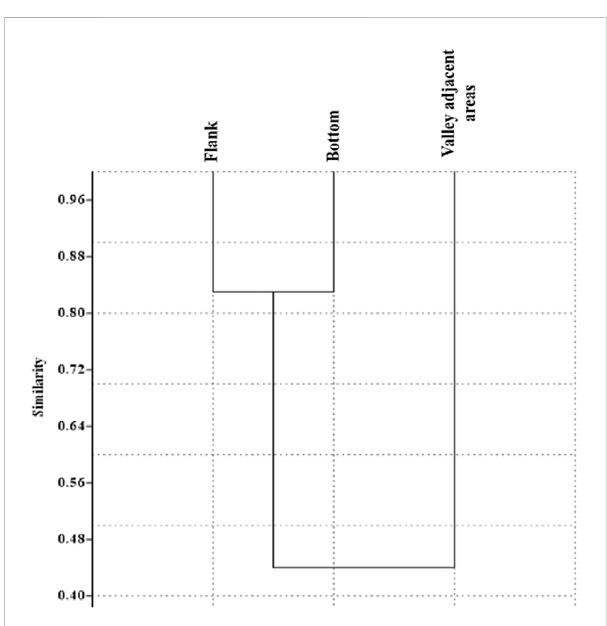
FIGURE 7 Similarity (Bray Curtis) in biotic composition among the valley bottom, valley fl ank, and adjacent